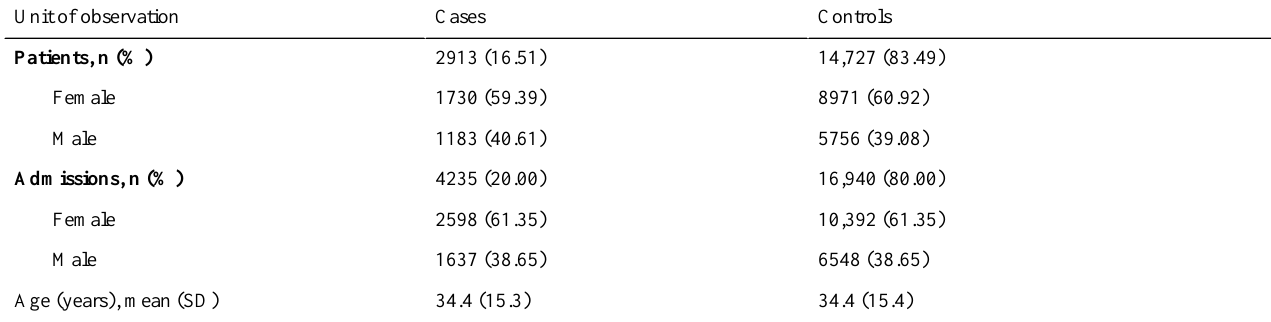
Table 1. Cohort patient- and admission-level statistics. ControlsCasesUnit of observation